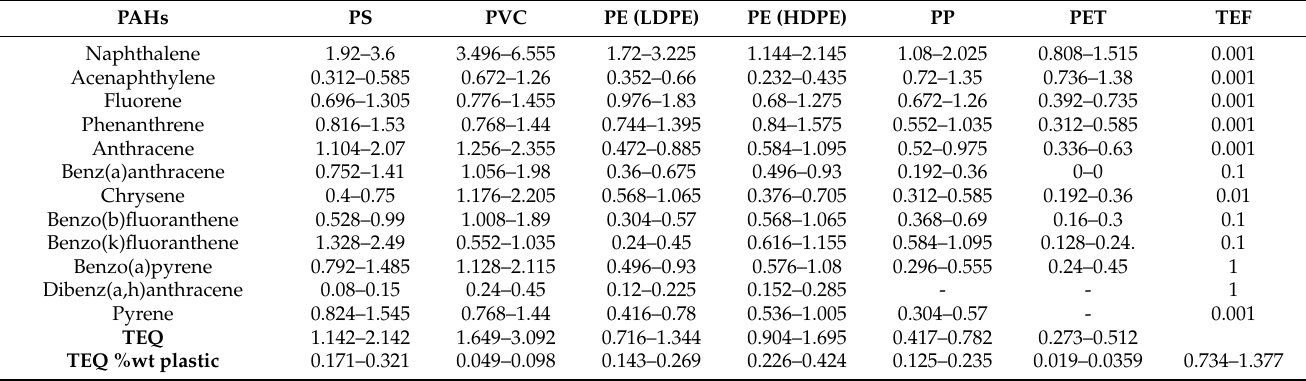
Table 12. Polycyclic aromatic hydrocarbon (PAH) concentrations in ( µ g m − 3 ) for six types of plastic